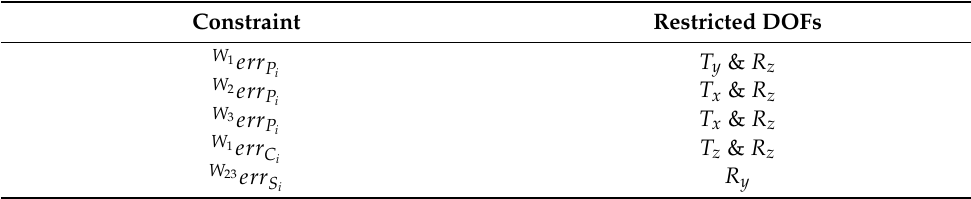
Figure 6. The motion restrictions between beams in the calibration experimental design. Table 1. Motion restrictions by the calibration constraints.